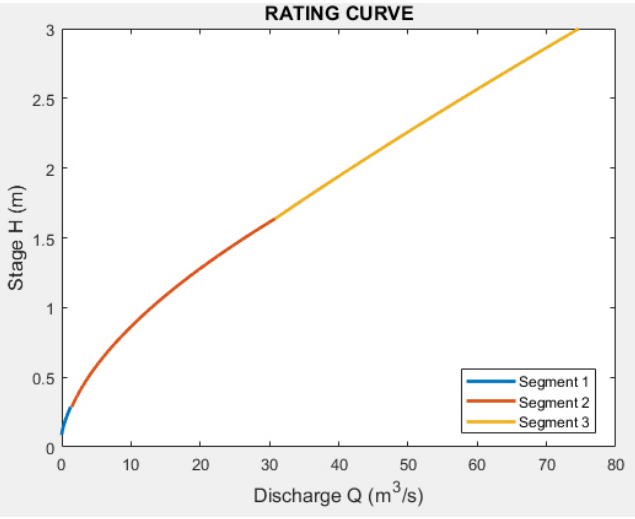
Figure 9. Example of rating curve composed of 3 segments.